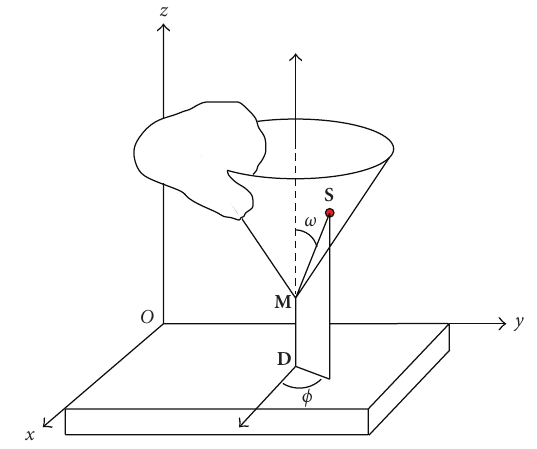
Figure 4: C 1 -cone and C 1 -conical Radon transform definition.